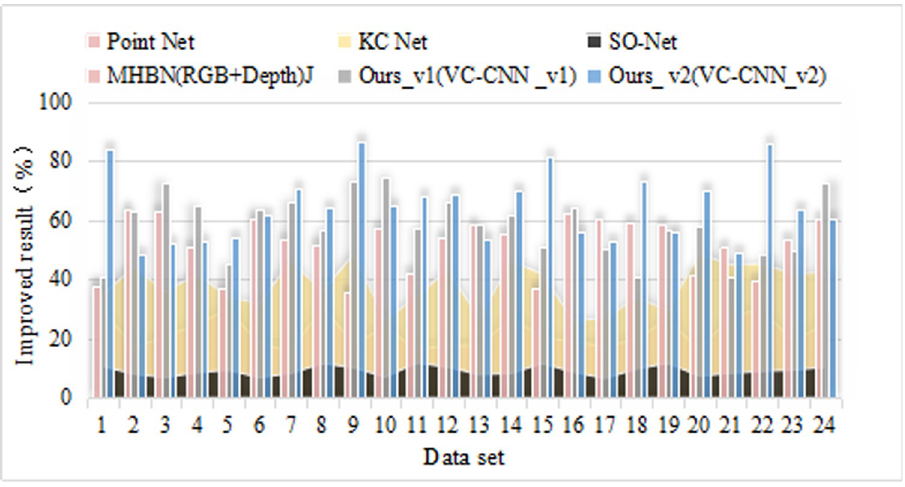
Fig 9. The result of comprehensive membership